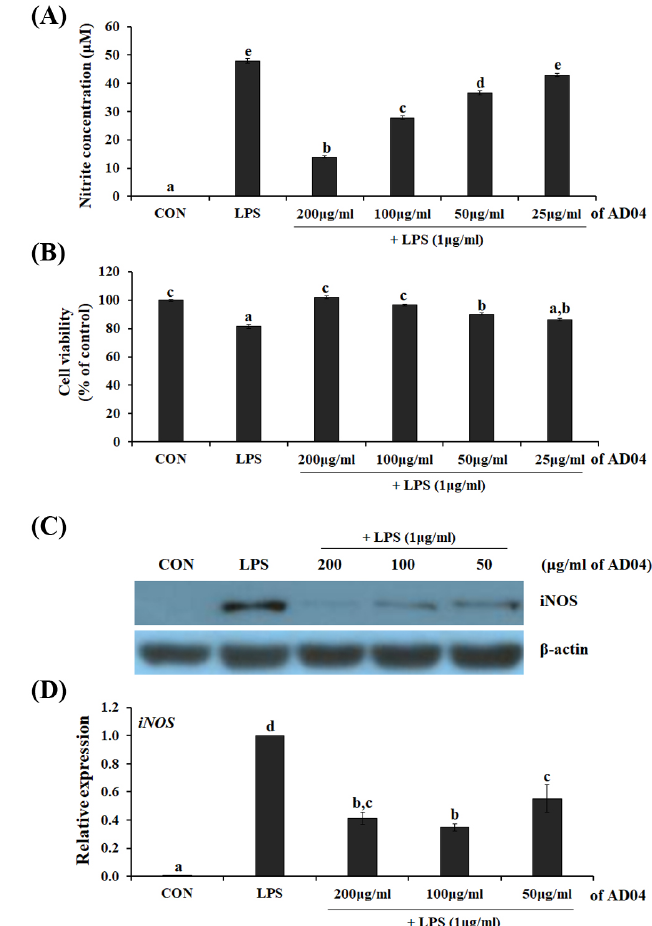
Fig. 3: Anti-inflammatory effect of BuOH fraction (AD04). The effect of AD04 on NO production (A) and cell viability (B) in LPS-stimula- ted RAW 264.7 cells were analyzed. NO contents were analyzed by the Griess assay, and cytotoxicity was determined by MTT assay. LPS-stimulated RAW 264.7 cells were treated with different con- centrations of AD04 for 24 h and subjected to Western blotting (C) and qRT-PCR (D) for iNOS . The transcript level of iNOS was nor- malized to the constitutive expression level of β-actin and expressed relative to the values of LPS alone. β-actin was used as an internal control for Western blotting. Values in the same column with diffe- rent superscripted letters are significantly different ( p < 0.05). Values are the mean ± SD of triplicate